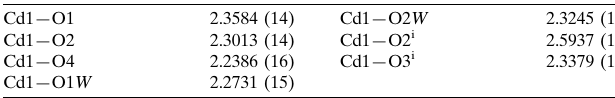
Selected bond lengths (A ˚ ).